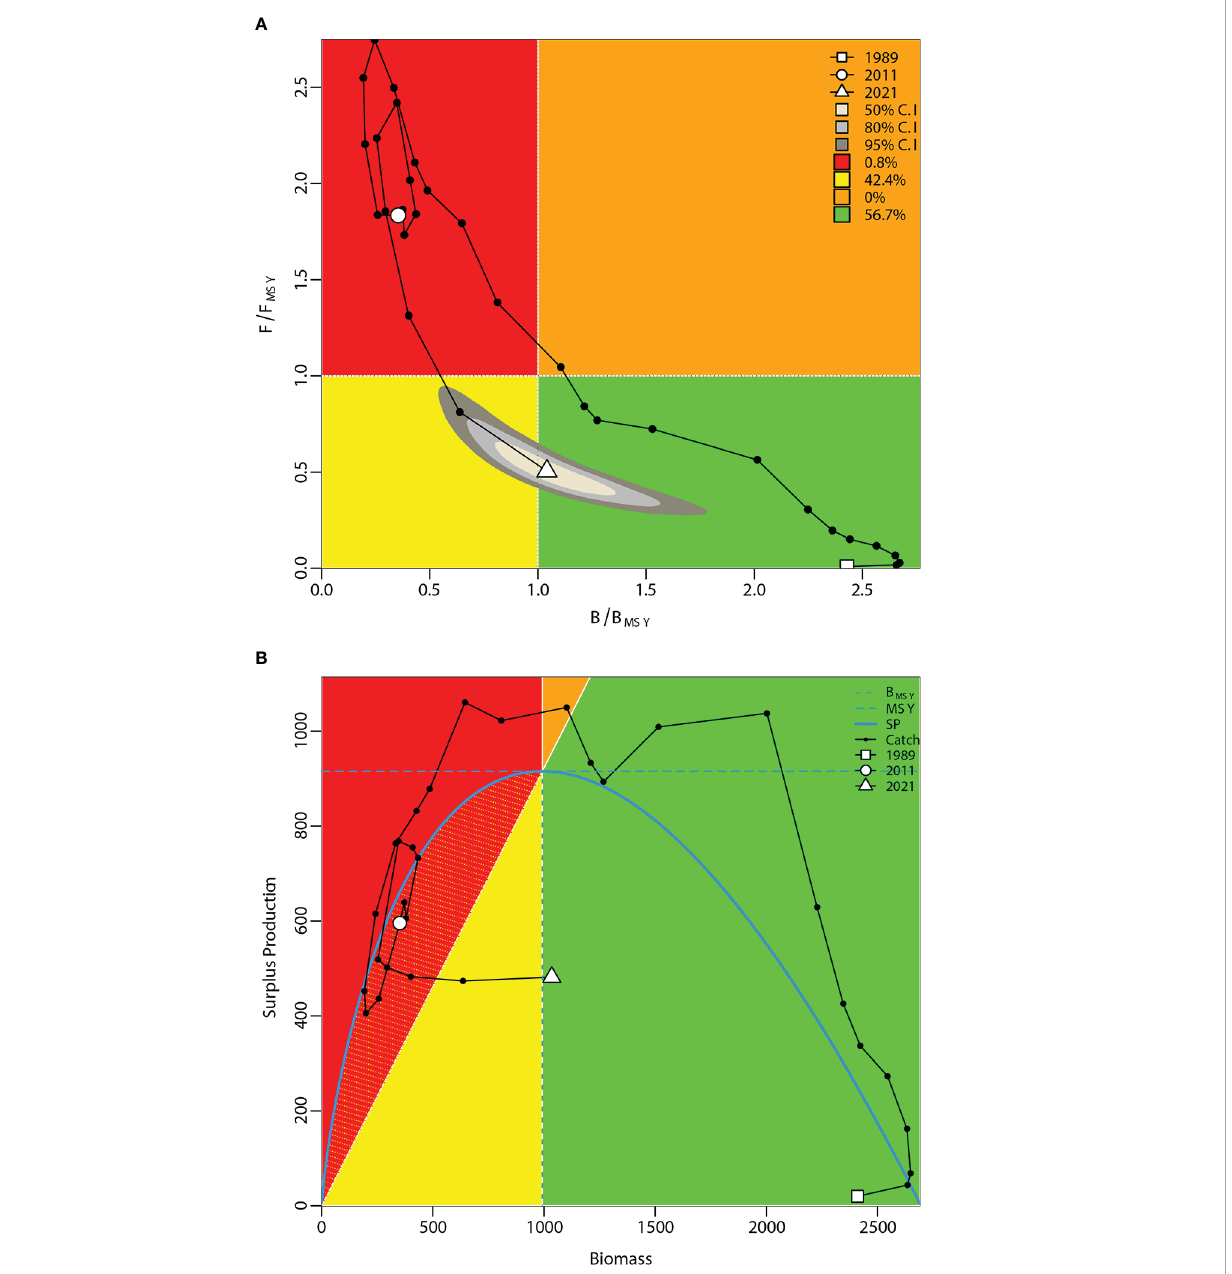
FIGURE 6 Kobe phase plot (A) and SP-phase plot (B) for the Japanese anchovy JABBA Fox-model based on survey biomass